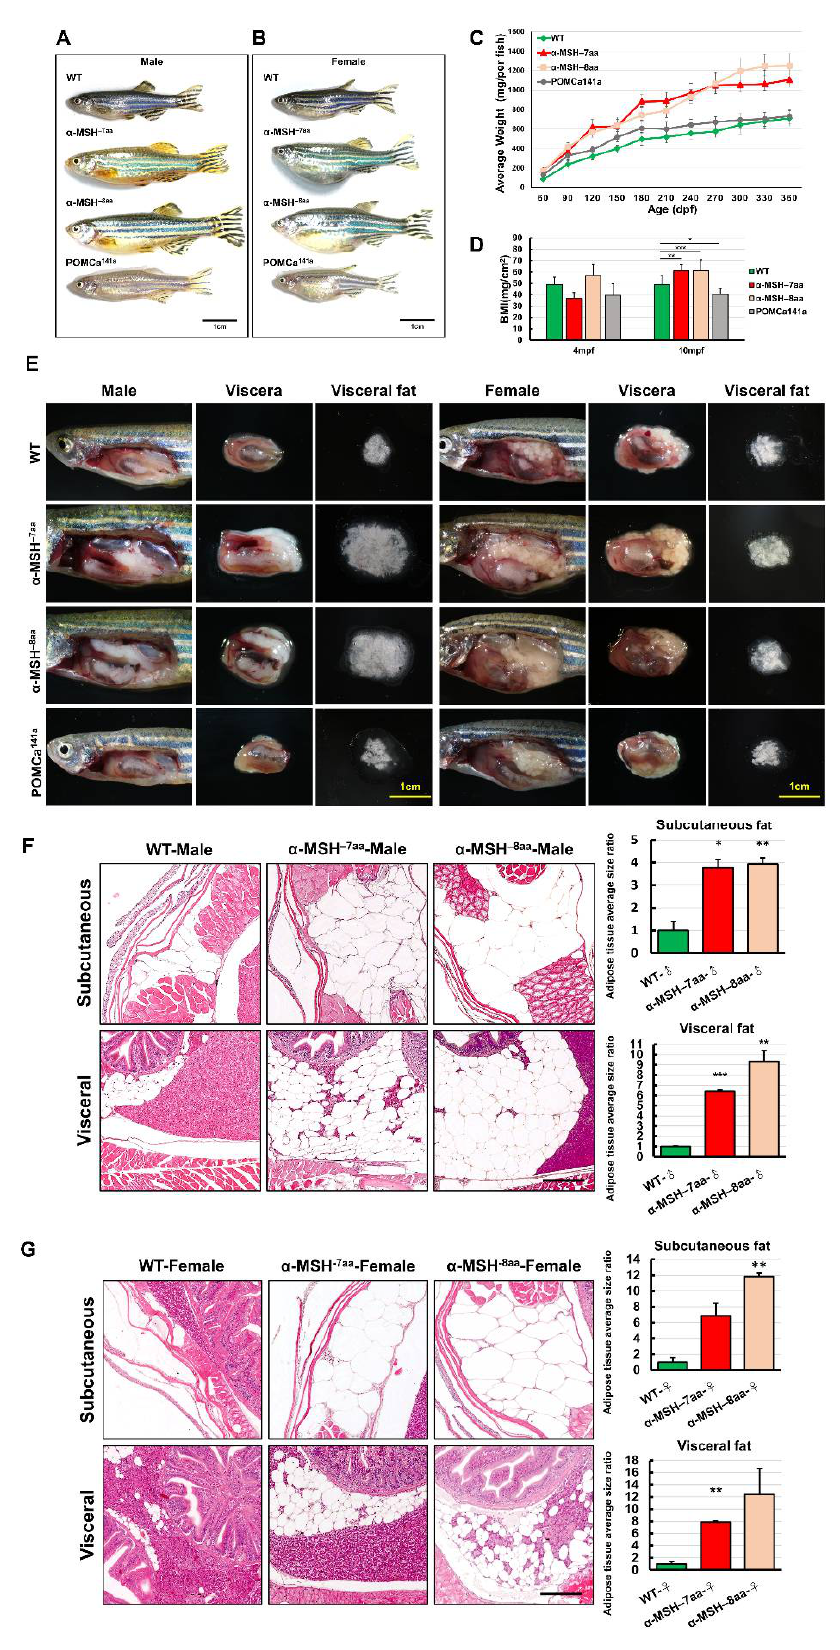
Figure 4. The level of α -MSH regulates somatic growth and sexual size dimorphism in pomca mutant adults. ( A , B ) Lateral view of F2 homozygous male ( A ) and female ( B ) mutants compared with WT controls at 12 mpf. Scale bars = 1 cm. ( C ) BW curves of zebrafish from the juvenile to adult stages in the three experimental male groups (WT, α-MSH -7aa , and α-MSH -8aa ; n = 20/group). ( D ) Bar graph